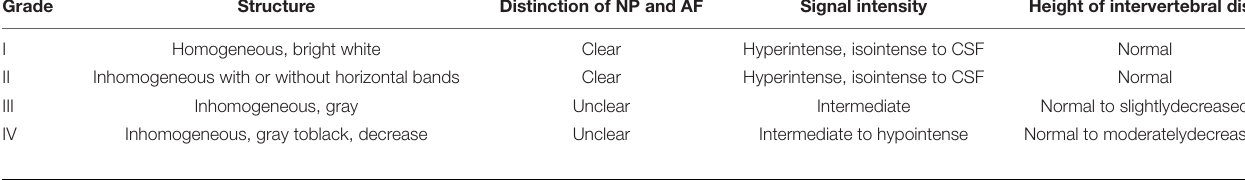
TABLE 2 | Definition of a Magnetic resonance imaging Grading Scale.